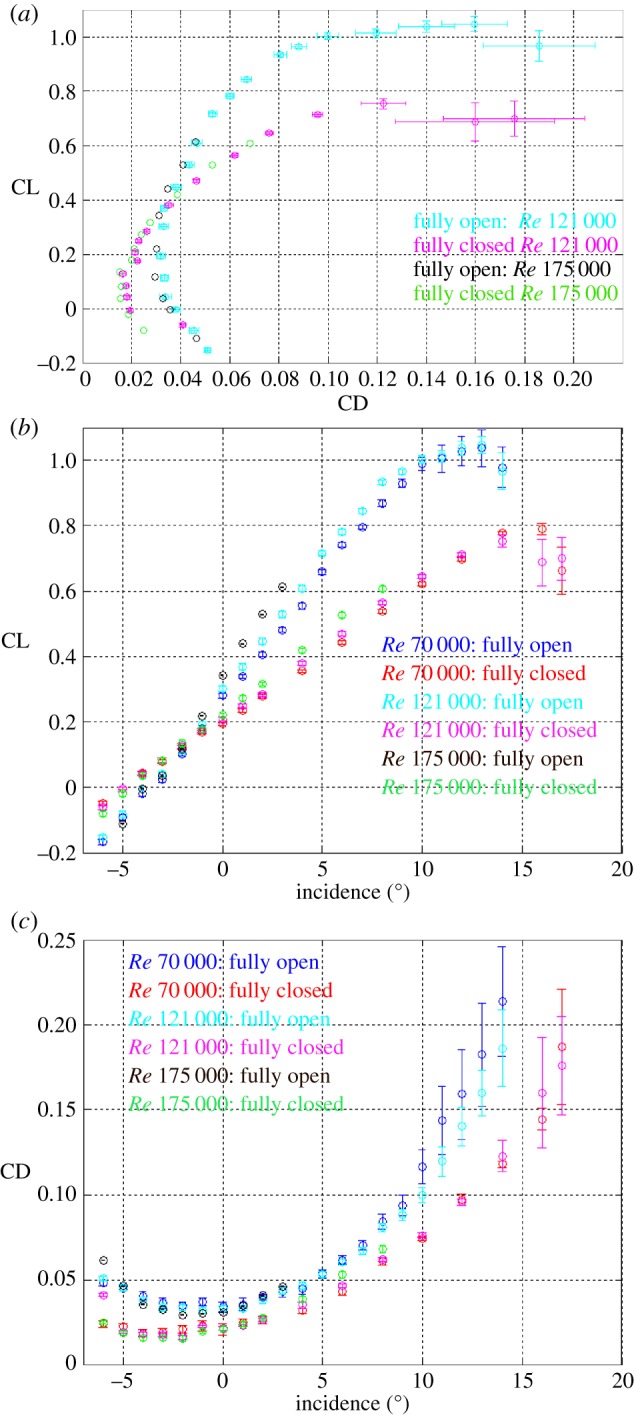
(a) Polar curves of the morphing wing obtained through wind tunnel measurements for Re 121 000 and 175 000 (error bars are fully contained inside the circular markers and therefore not shown). (b) CL and (c) CD as a function of incidence for the three tested values of Reynolds numbers (70 000, 121 000 and 175 000).